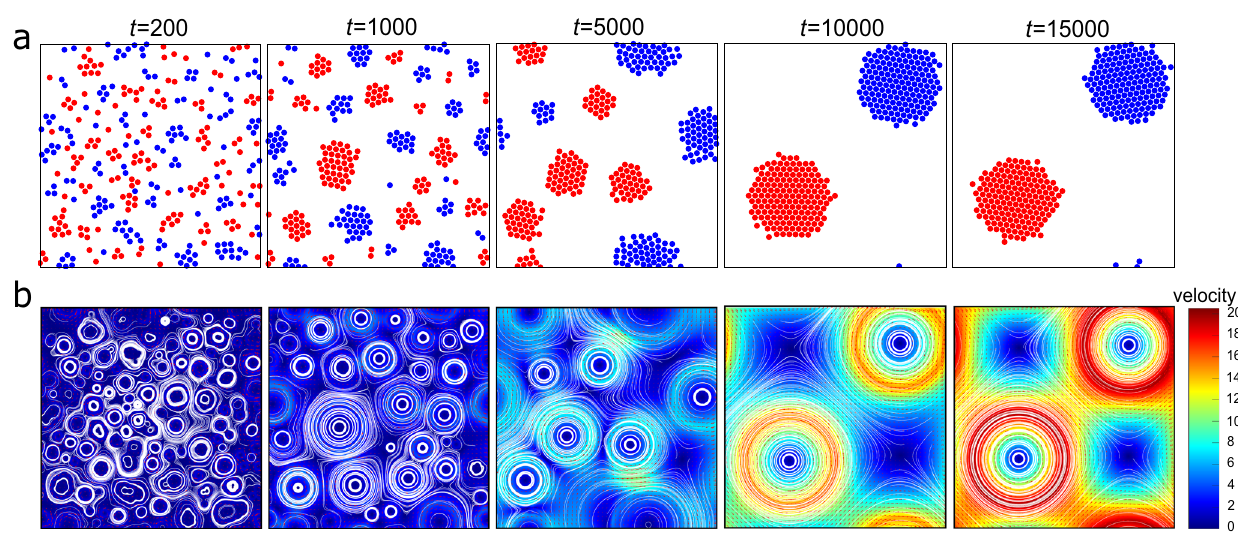
Fig. 9 Phase separation without the nonlinear convective term. a Temporal evolution of the phase-separation pattern at Φ = 0.5 and Re = 10.8 (see also Supplementary Movie 6).Red and blue particles represent counter-clockwise (CCW) and clockwise(CW) rotating disks. b Streamline patterns and the spatial distribution of the velocity magnitudes corresponding to the images in a. The colour bars show the velocity